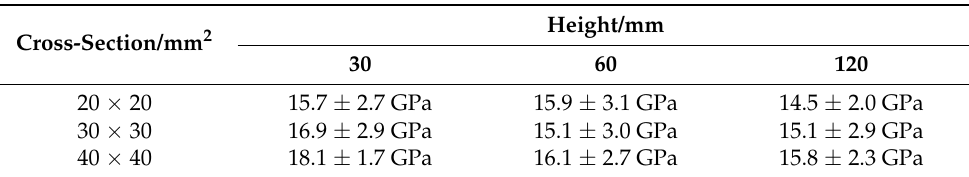
Table 3. Average values and standard deviations of the longitudinal modulus of elasticity for various lengths and cross-sections of specimens of Pinus pinaster. From [167].